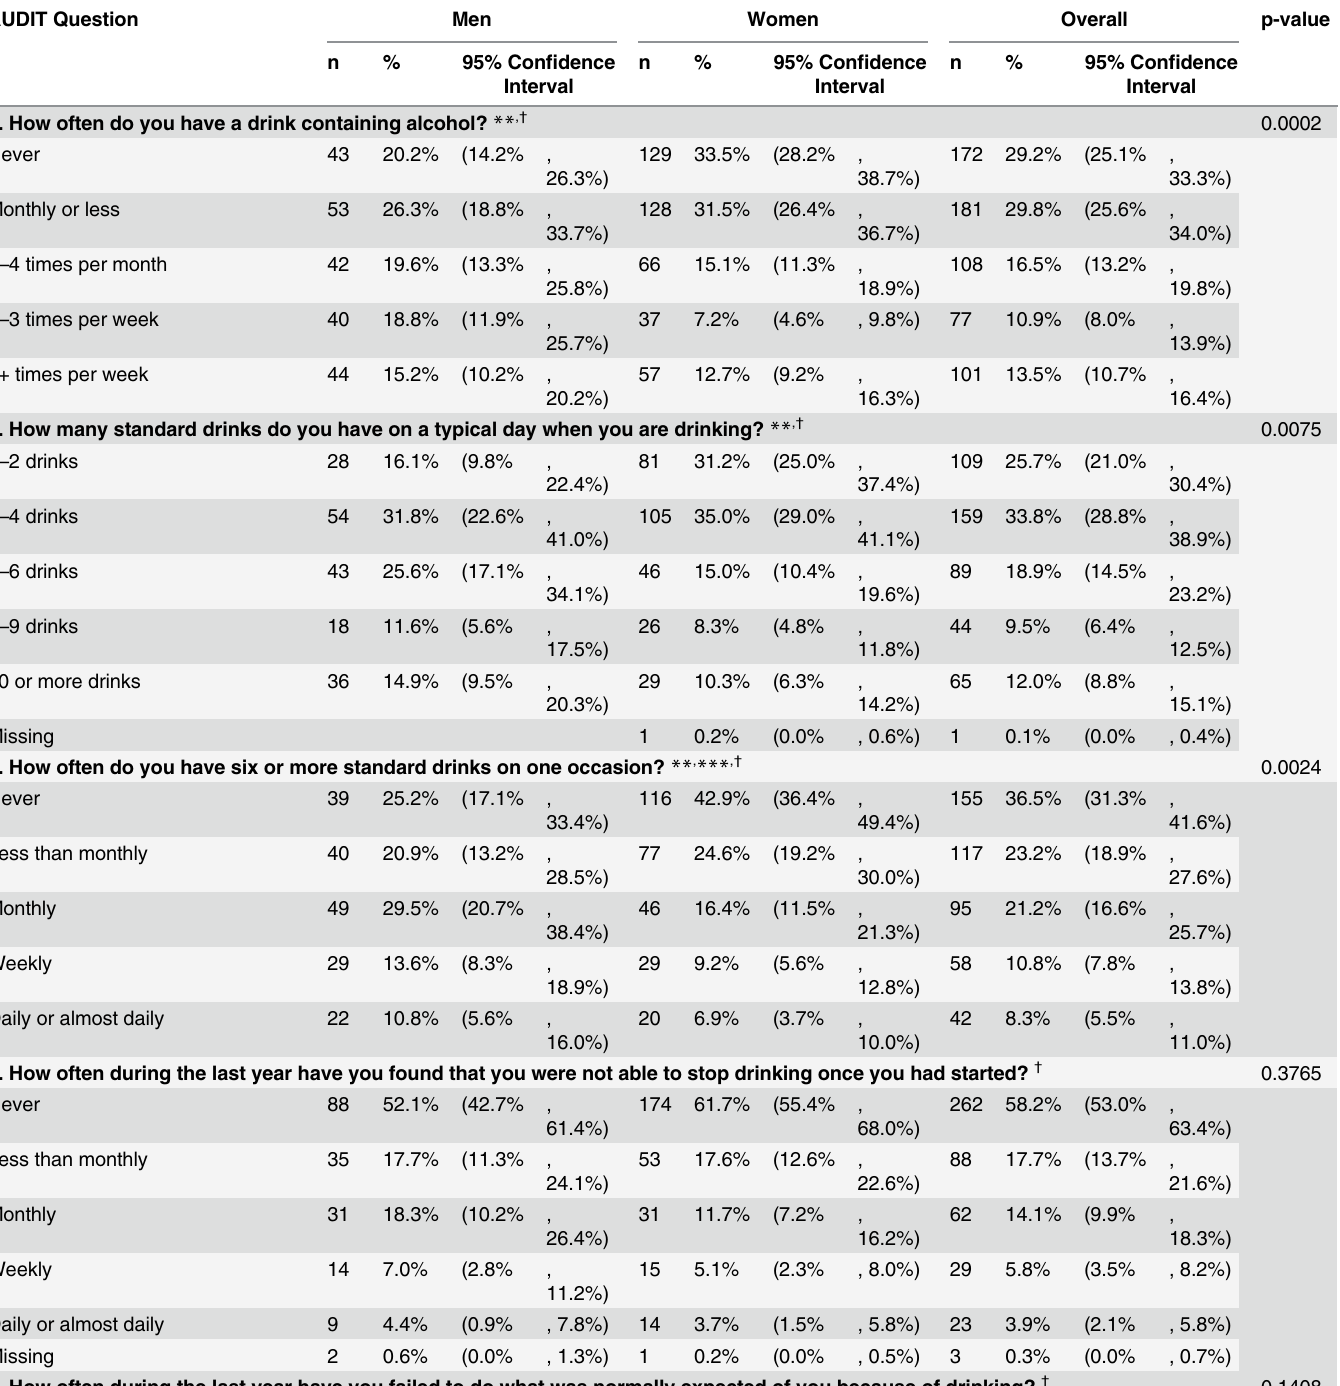
Table 2. AUDIT Survey by Sex *